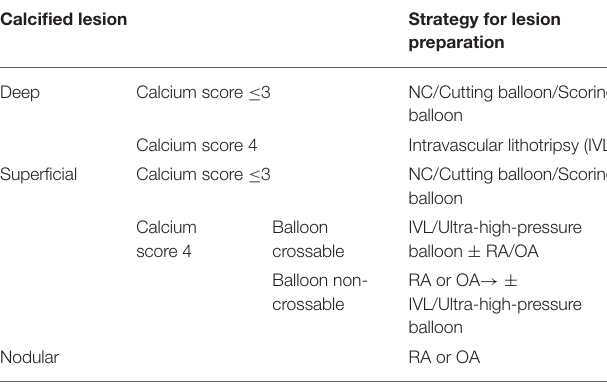
TABLE 5 | The calcified lesion modification devices according to its location and OCT calcium score. Calcified